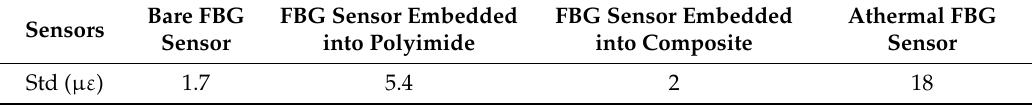
Table 2. Maximum standard deviation in measurements of all of the FBG